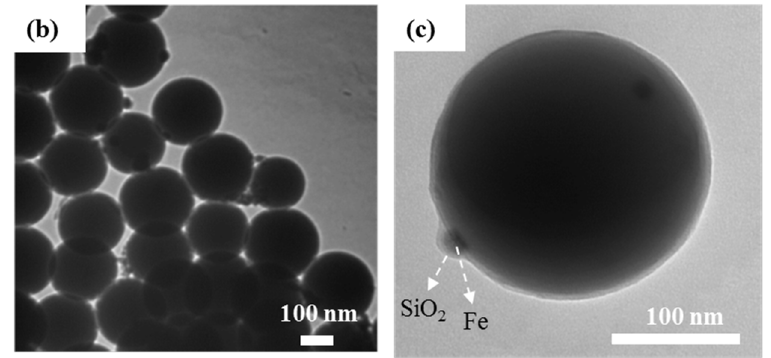
Figure 2. ( a ) XRD diffraction patterns of the SiO 2 @Fe/SiO 2 composite spheres prepared at different concentrations of FeCl 3 ∙ 6H 2 O. Fe NPs prepared under the SiO 2 sphere ‐ free condition were also